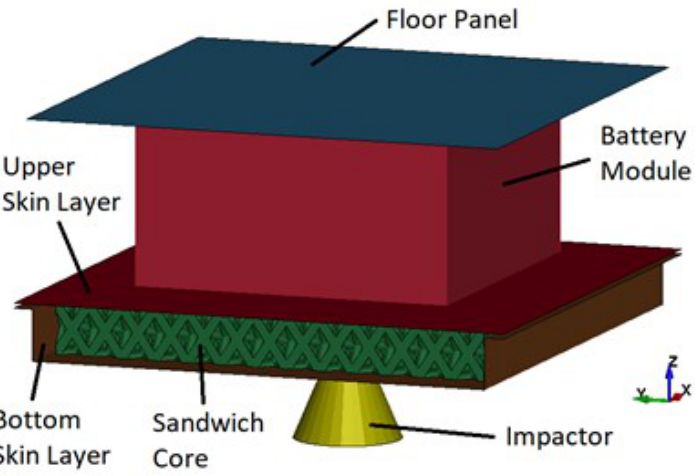
Figure 12. Battery Protection Simulation Modelling